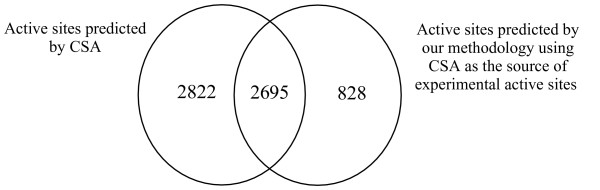
Venn diagram comparing the active sites predicted by our methodology using the CSA experimental active sites with the predicted active site residues annotations in CSA.